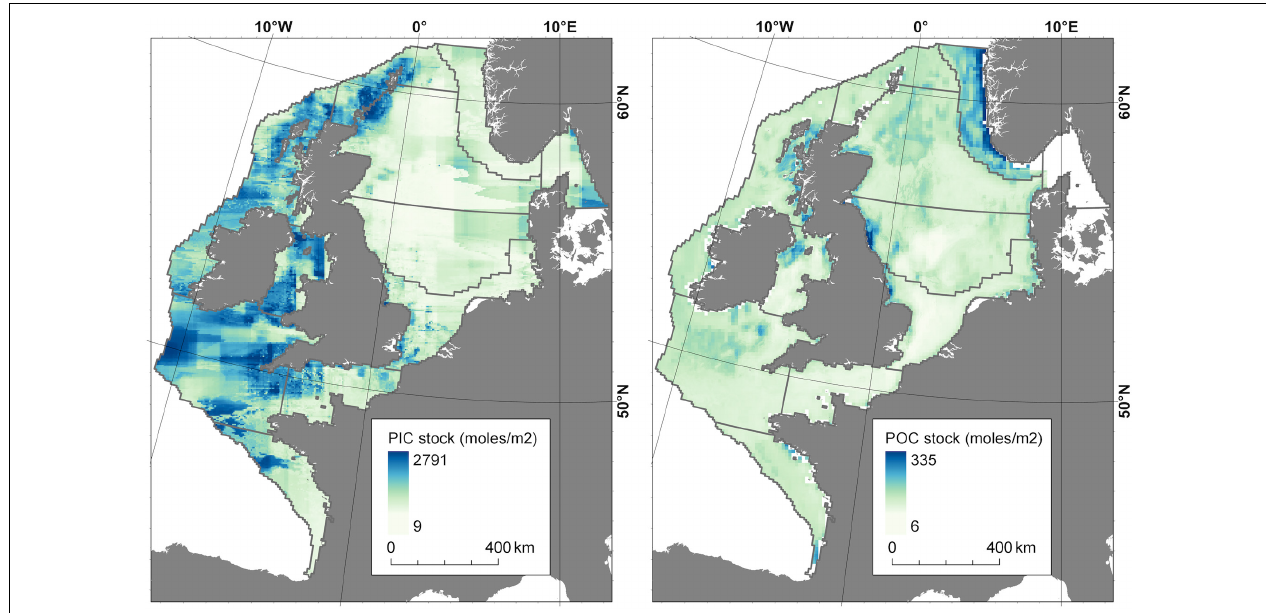
FIGURE 3 | The benthic concentration of particulate inorganic carbon (left) and particulate organic carbon (right) , modeled using PIC and POC data and a suite of predictor variables ( Supplementary Material Part A ).